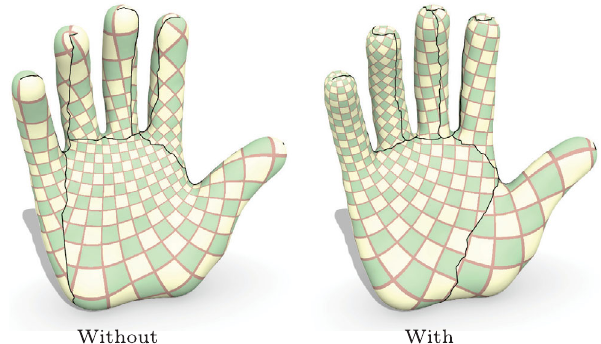
Fig. 10 Global seamless